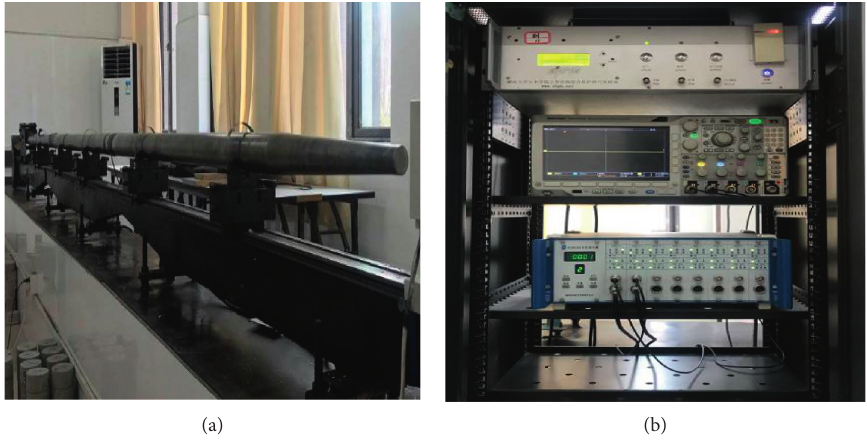
Figure 5: The SHPB experimental equipment. (a) SHPB test device. (b) Gas pressure control and data acquisition system.